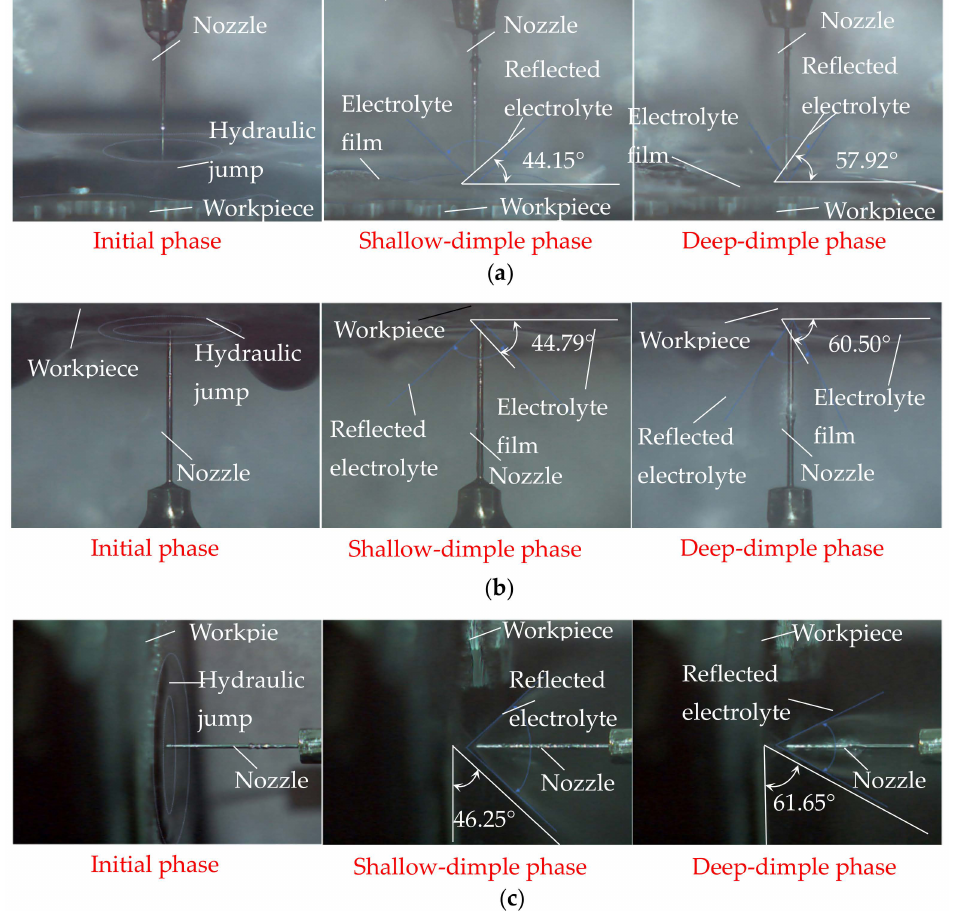
Figure 5. Observational results of the flow field during Jet-ECM in di ff erent phases when the electrical voltage was 15 V, the nozzle’s inner diameter was 170 µ m, and the working gap was 100 µ m. ( a ) Vertically downstream orientation; ( b ) vertically upstream orientation; ( c ) horizontal